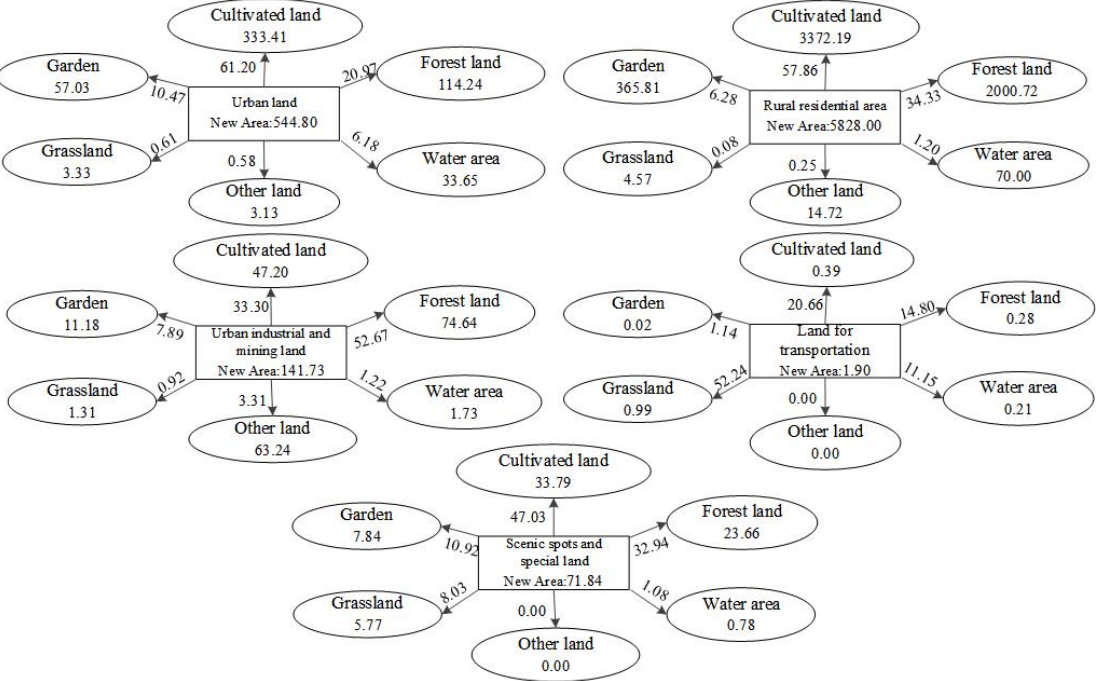
Figure 4. End points for the reduction in urban–rural construction land in Qixingguan District from 2009 to 2020 (hm 2 ,%).